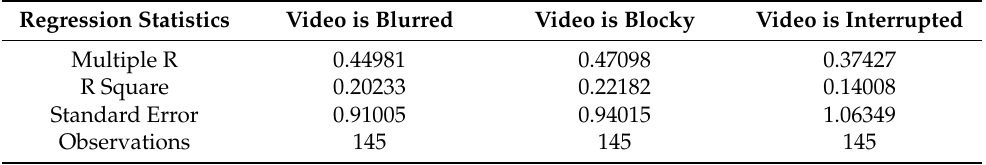
Table 5. The summary output for the video group of degradations.